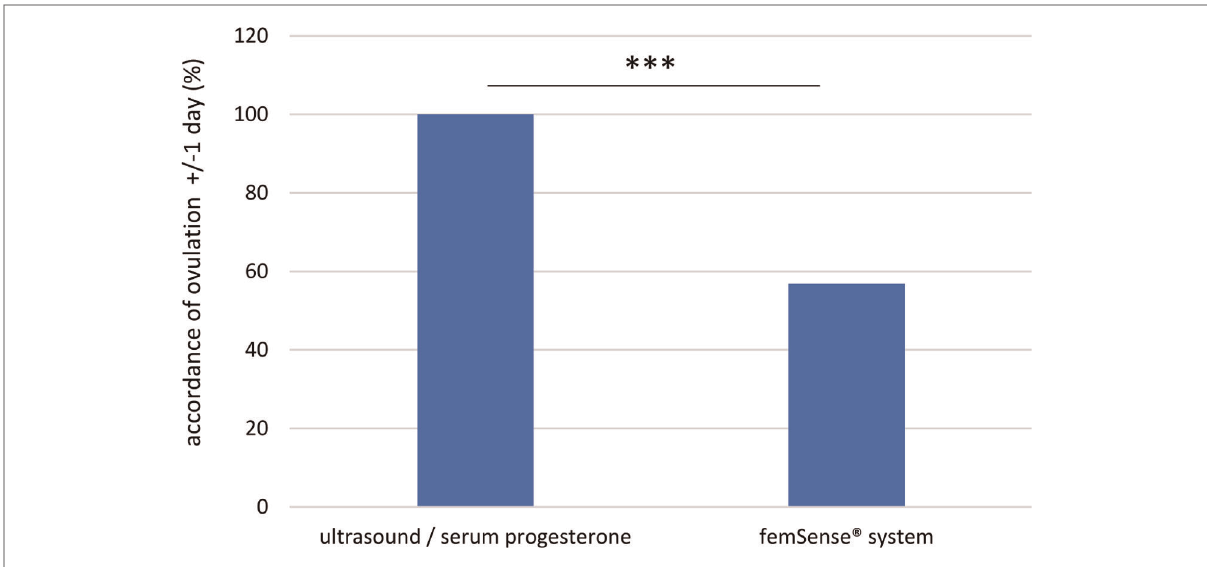
FIGURE 5 Exact accordance of ovulation con fi rmation (±/ − 1 day): the femSense ® system con fi rmed the correct ovulation day in 42 (56.8%) of all participants. Signi fi cant differences are indicated as follows: *** p